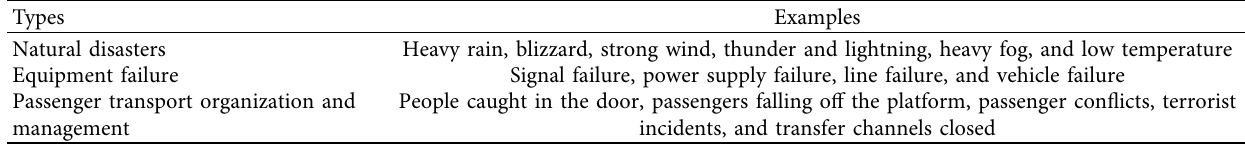
Table 1: Types of urban rail transit emergencies.